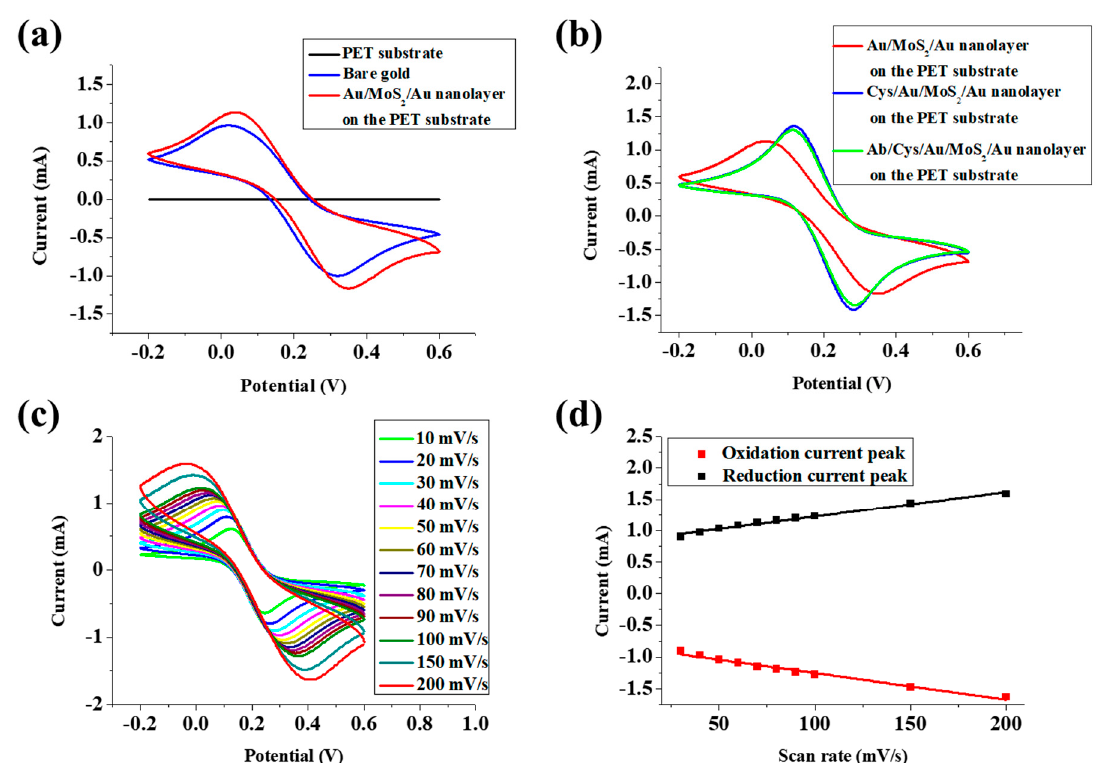
Figure 4. ( a ) Cyclic voltammograms of the PET substrate, bare gold, and the Au/MoS 2 /Au nanolayer on the PET substrate. ( b ) Cyclic voltammograms of the Au/MoS 2 /Au nanolayer on the PET substrate, the Cys/Au/MoS 2 /Au nanolayer on the PET substrate, and the Ab/Cys/Au/MoS 2 /Au nanolayer on the PET substrate. ( c ) Cyclic voltammograms of the Au/MoS 2 /Au nanolayer on the PET substrate at scan rates increasing from 10 to 200 mV/s. ( d ) Linear-response plot of redox current peaks of the Au/MoS 2 /Au nanolayer on the PET substrate against scan rates.